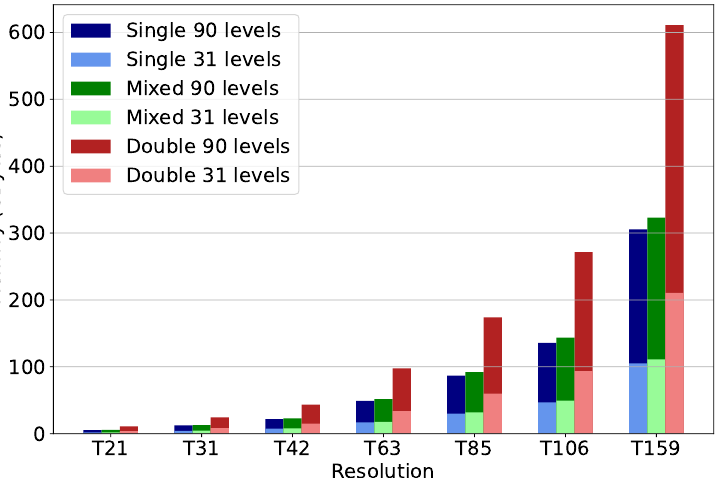
Figure 5. Memory requirements in HPC simulations with KPP MOM chemical mechanism for different vertical configurations (31/90 levels) using single (blue/light blue), mixed (green/light green) and double (red/light red) precision for different spectral